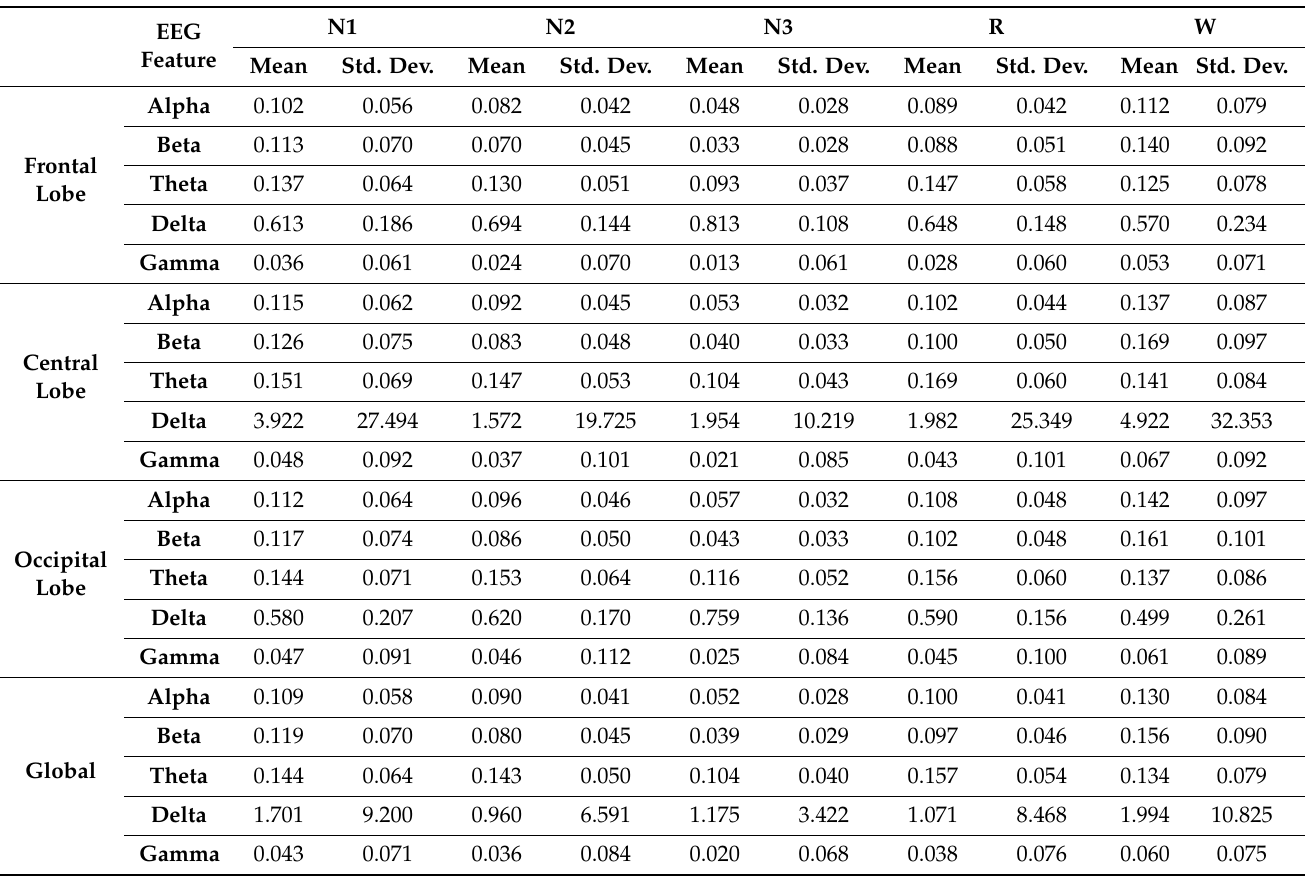
Table 2. Statistical results (Mean and Standard Deviation) of EEG spectral features ( δ , θ , α , β , and γ ) in the frontal, central, and occipital lobes during sleep stages W, N1, N2, N-3, and R. Global indicates the average measures of features of the frontal, central, and occipital lobes.